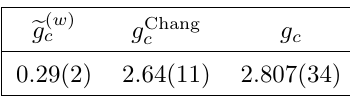
Table 1 . Values of the critical coupling in the (cid:30) 4 theory. The value this paper from eq. (1.5), g Chang